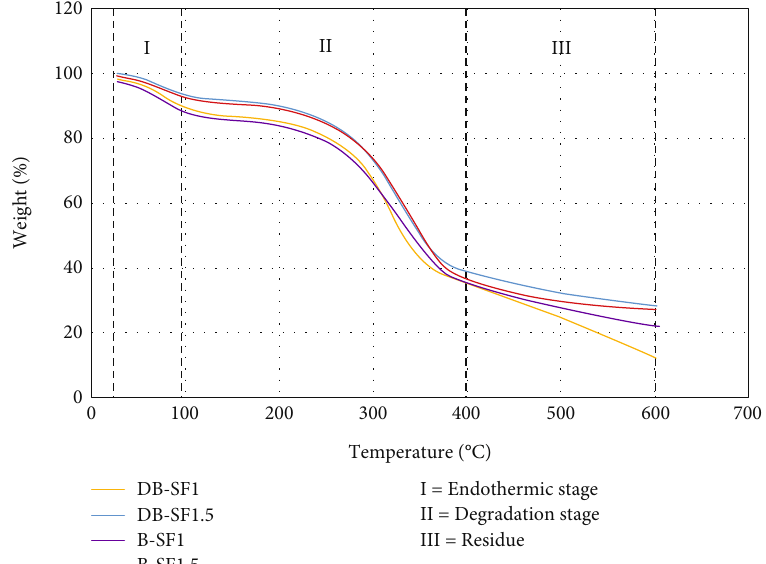
Figure 12: Thermogram analysis results of TGA biofoam cup bagasse, where DB is depithed bagasse, B is bagasse, SF1 is the ratio of soybean fl our to bagasse 1, and SF1.5 is the ratio of soybean fl our to bagasse 1.5. Table 3: Thermal properties of biofoam cup.